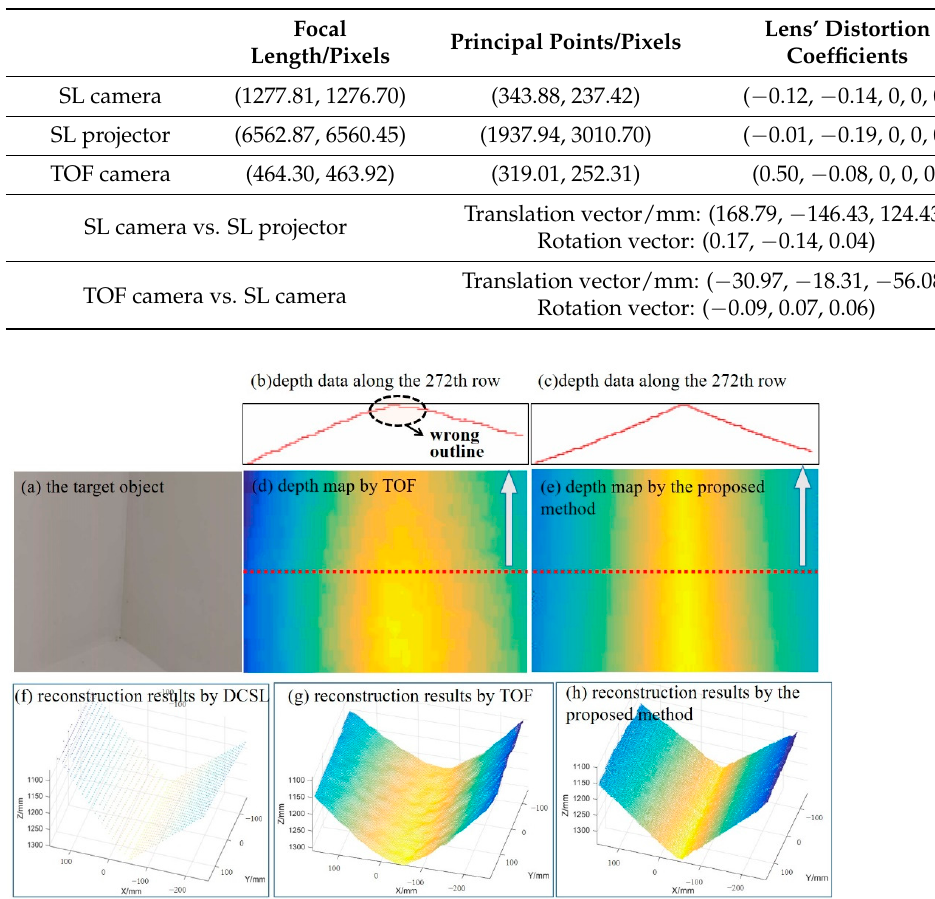
Figure 8. Reconstruction results of two perpendicular planes. ( a ) the target object; ( b ) estimated depth by TOF along the 272nd row; ( c ) estimated depth by the proposed method along the 272nd row; ( d ) estimated depth map by TOF; ( e ) estimated depth map by the proposed method; points clouds reconstructed by ( f ) DCSL; ( g ) TOF; and ( h ) the proposed method respectively.